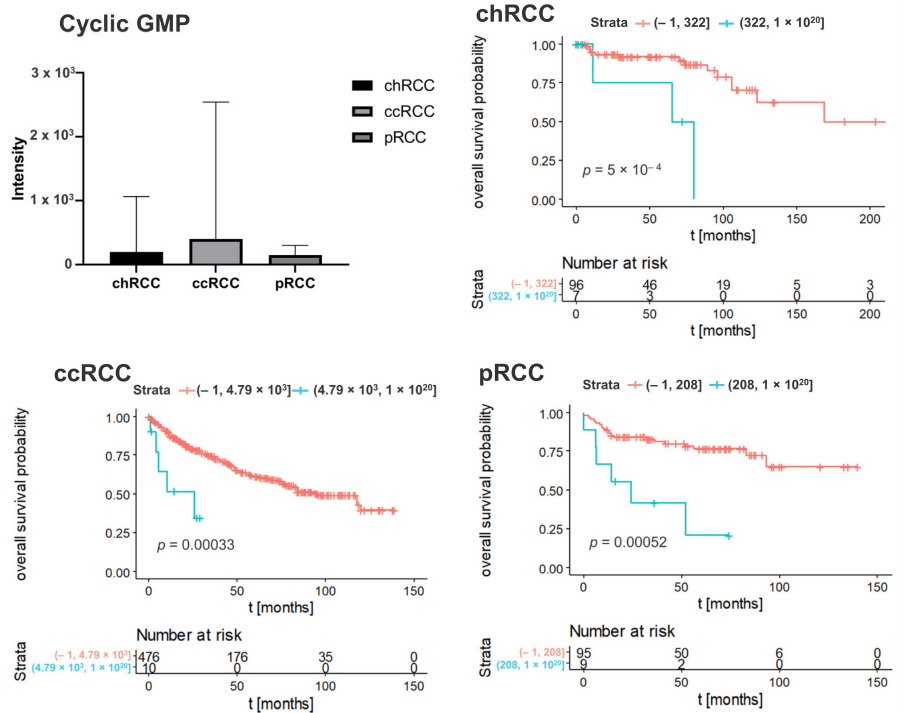
Figure 3. Kaplan–Meier curve of cyclic GMP in different subtypes of renal tumor. Blue lines indicate survival in patients with high intensity of the respective mass. Red lines indicate survival in patients with low intensity of the respective mass. Statistical significance testing was performed using the Kruskal–Wallis test (alpha = 0.05).